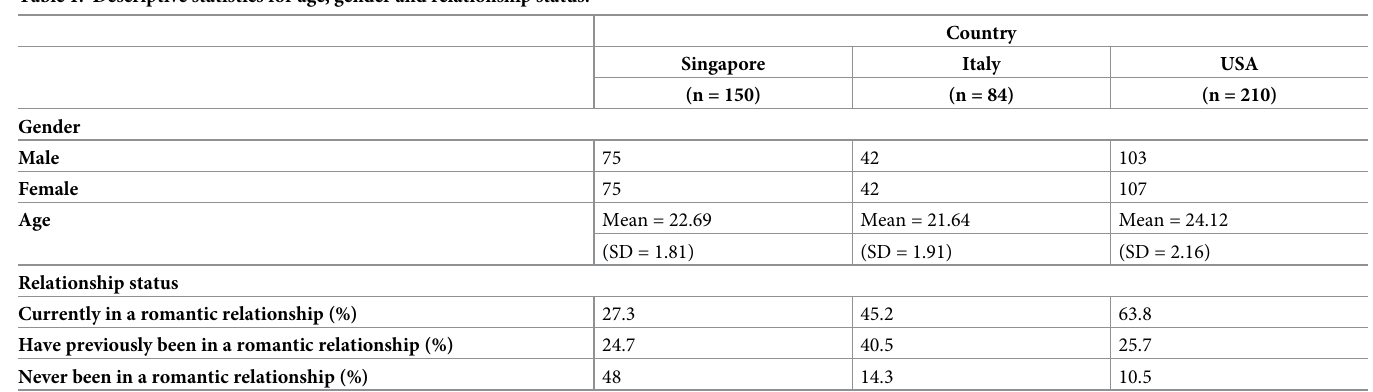
Table 1. Descriptive statistics for age, gender and relationship